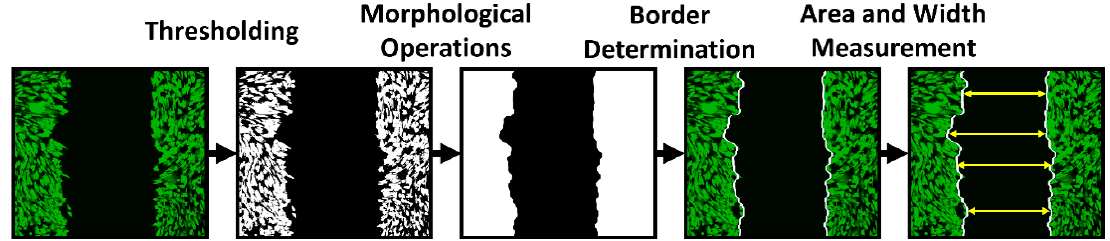
Figure 11. Basic pipeline of image processing approach for automatic wound healing analysis. From left to right: original grey-scale image with pseudo-colored cells; thresholded binary image; segmented image after application of morphological operations with detected scratch border; original image merged with detected scratch border; schematic of scratch width measurement.